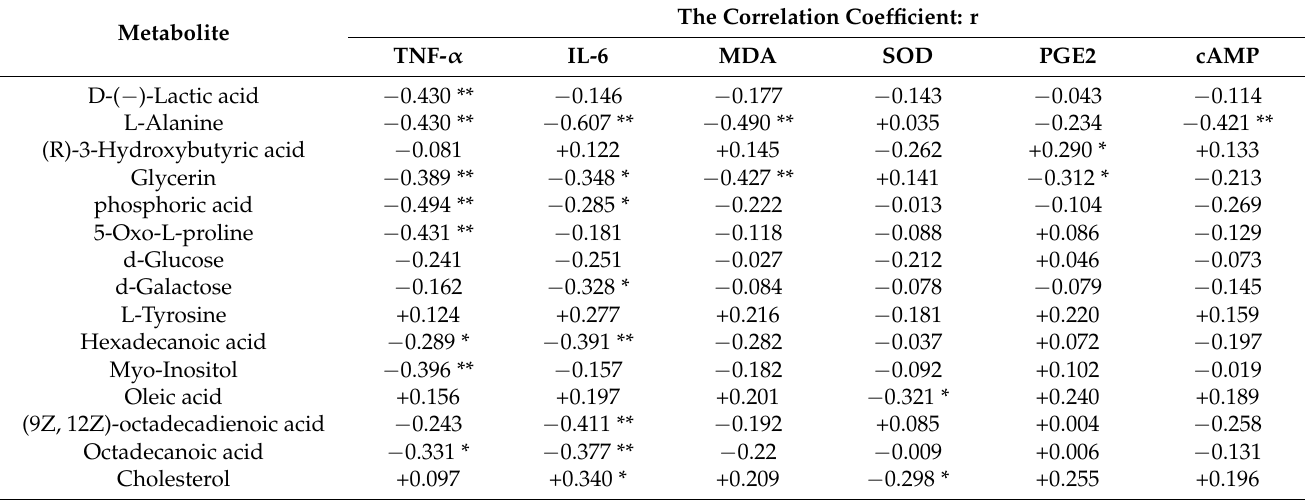
Table 2. Pearson correlation coefficient between biomarkers and pharmacodynamic